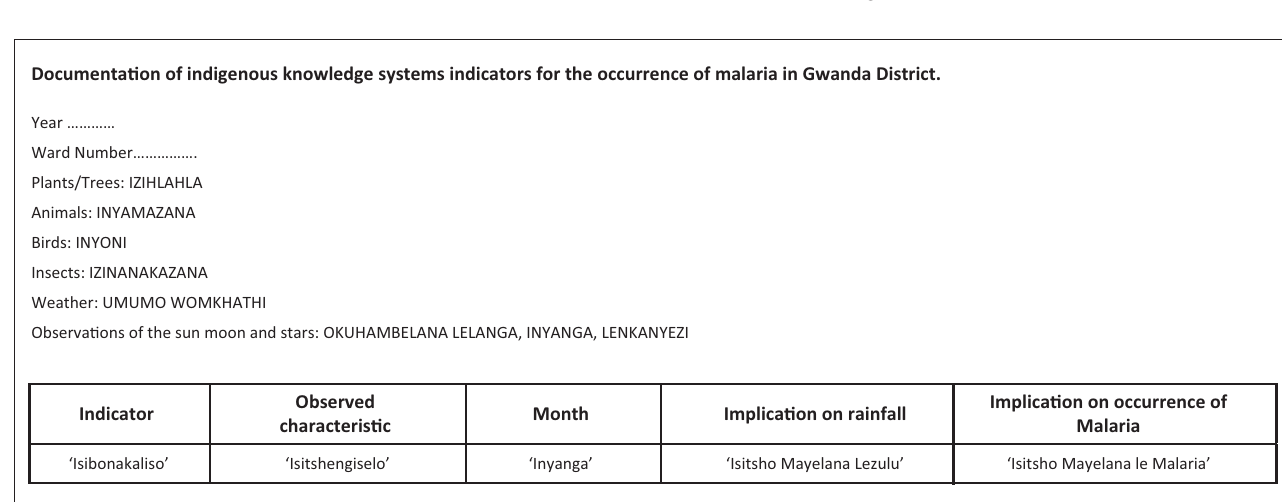
Documenta(cid:22)on of indigenous knowledge systems indicators for the occurrence of malaria in Gwanda District. Year